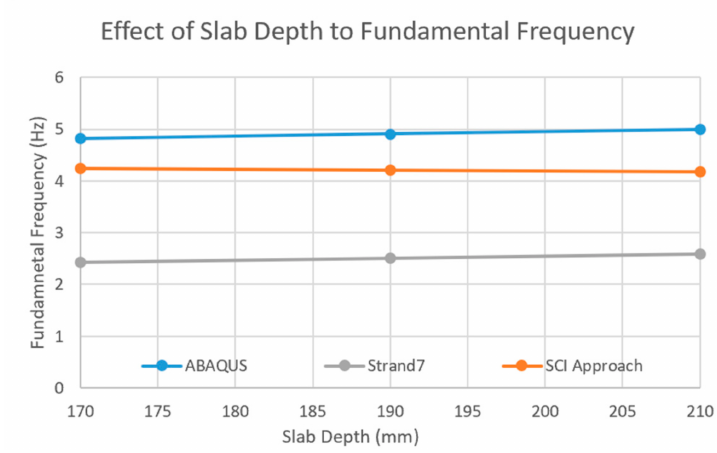
Figure 14. Comparison of Fundamental Frequency between Different Slab Depths.